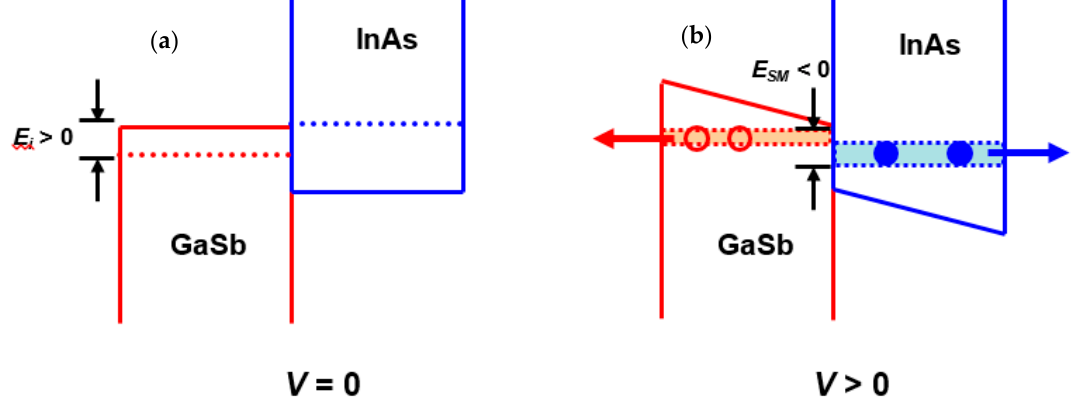
Figure 1. Schematic of the energy alignment for adjacent InAs and GaSb QWs: ( a ) in equilibrium and ( b ) under bias, where the solid blue and red lines are the conduction and valence-band edges, respectively, in the bulk materials. In the absence of bias, quantum confinement leads to an energy gap E g between the lowest conduction and highest valence-band states (blue and red dotted lines, respectively), whereas under bias, a semimetallic overlap E SM is imposed that leads to the generation of equal electron and hole densities. The applied field also causes both carrier types to flow away from the interface (arrows), requiring that they be replaced on an ongoing basis to maintain quasi-thermal equilibrium populations. Adapted from Ref. [70].